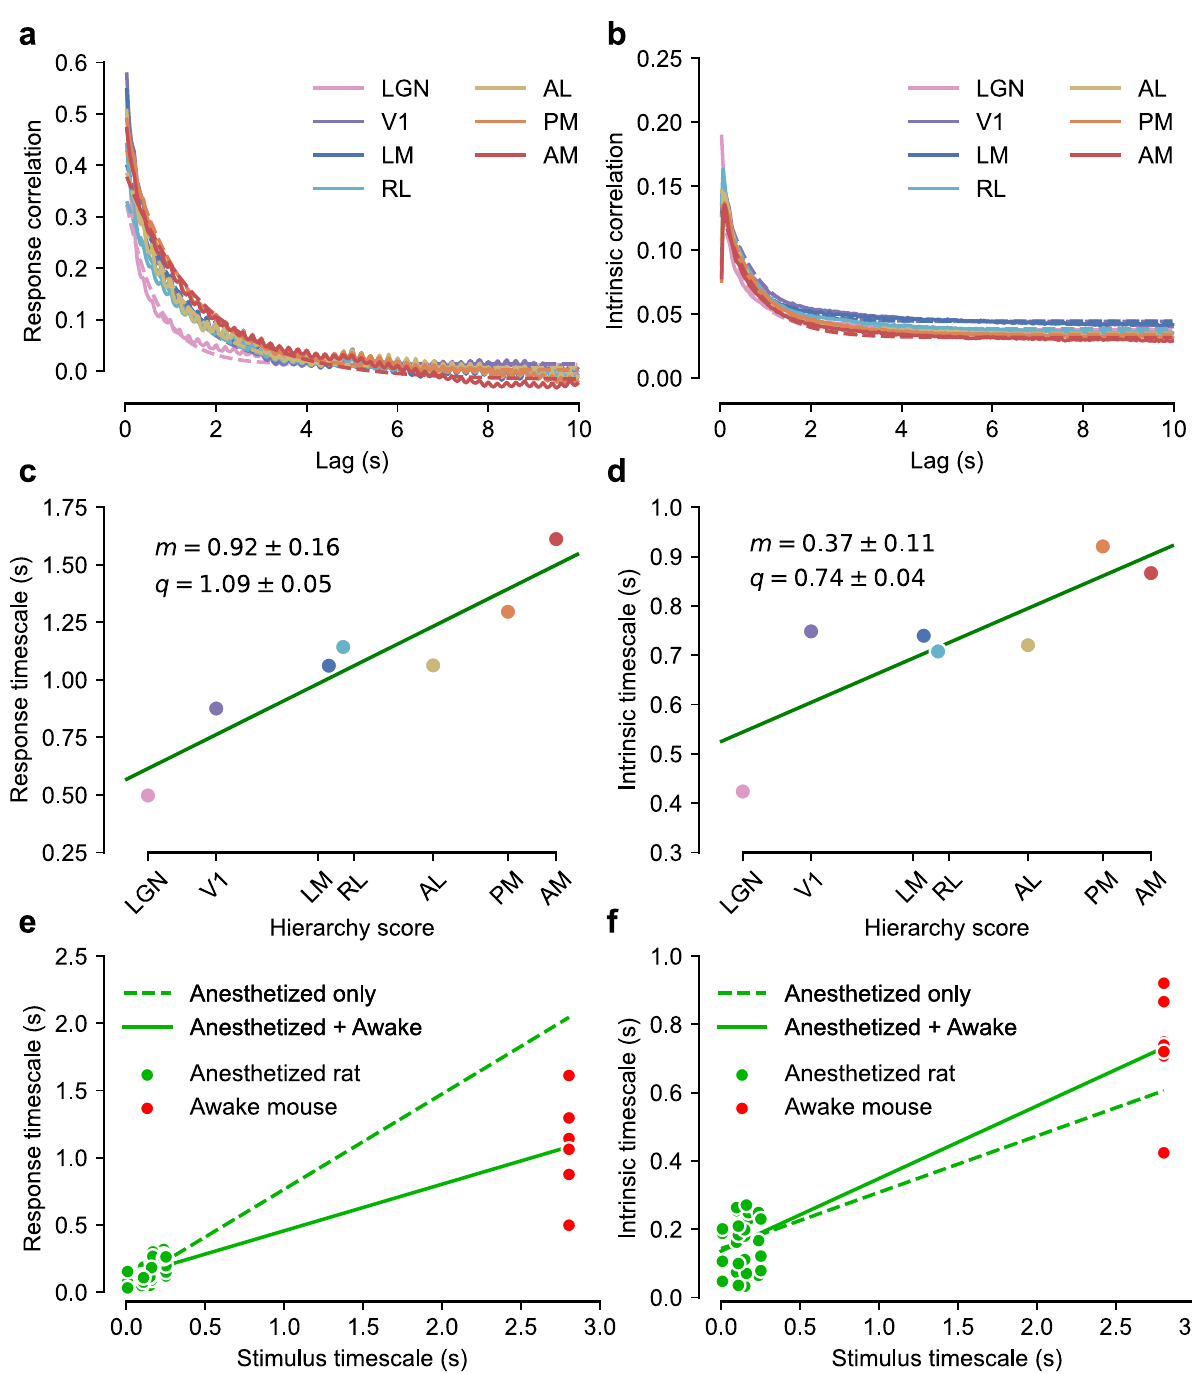
Fig. 7 Timescale of stimulus-driven responses and intrinsic neuronal activity in awake mice (Allen dataset). a Correlations in the responses to a 120-s- long movie clip that were recorded across seven visual areas of the mouse visual system by ref. 12 and are part of the Allen dataset. The same color-code used by ref. 12 denotes the different areas (see key). Dashed lines with matching colors indicate the corresponding exponential fi ts. b Same as in a but for the intrinsic correlations. c The time constants of the exponential fi ts to the correlation functions shown in ( a ) are plotted against the anatomical hierarchy score of the corresponding visual areas, as measured by ref. 68 . m : slope of the best linear fi t. q : intercept of the best linear fi t. d Same as in c but for the intrinsic correlations shown in b . e All the response timescales (without area distinction) obtained in anesthetized rats (green dots; same data as in Fig. 4b) and in awake mice (red dots; same data as in c ) are plotted against the corresponding stimulus timescales. The dashed green line shows the linear regression performed just on the rat anesthetized data, while the solid line shows the regression performed on the combined data. f Same as in e but for the intrinsic timescales previously shown in Fig. 4d for the anesthetized rat recordings (green dots) and in d for the awake mouse recordings (red dots). Source data are provided as Source Data fi